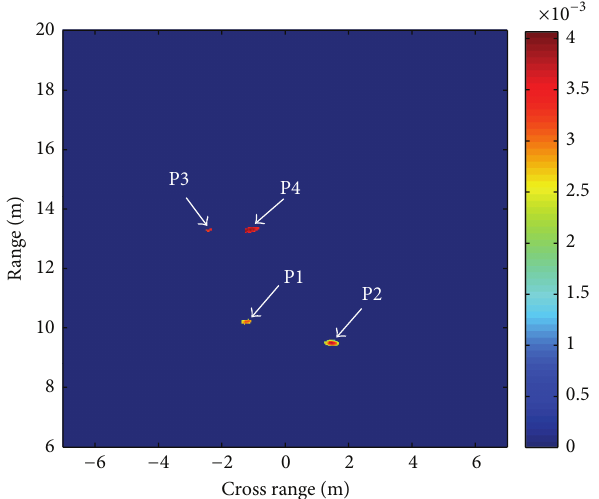
Figure 15: Two true targets as well as three ghosts have been detected in the image after CFAR processing.